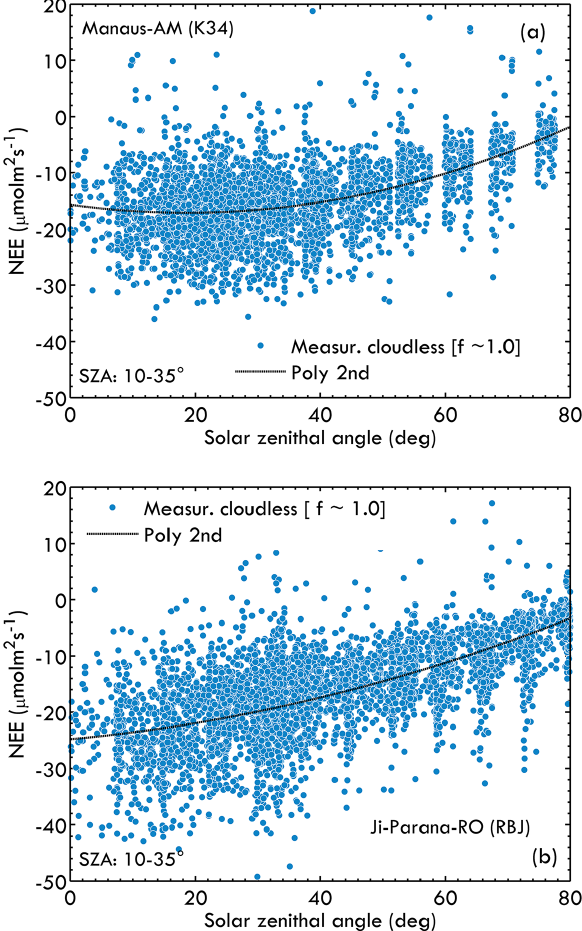
Figure 3. Relationship between NEE and solar zenithal angle (SZA) for clear-sky conditions ( f = 1 . 0) at K34 (a) for a poly 2nd fit with R 2 = 0 . 27 and p < 0.01, and at the RBJ (b) for a 2nd order polynomial fit with R 2 = 0 . 60 and p <